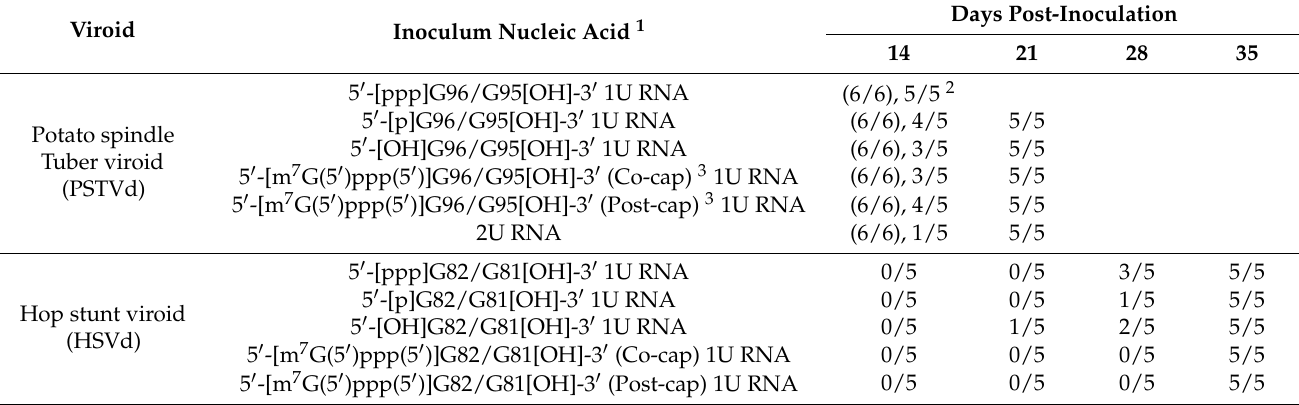
Table 3. Time-course of the infection rate of plants inoculated with monomeric viroid RNA possessing a different 5 (cid:48) -terminus. Viroid Inoculum Nucleic Acid 1